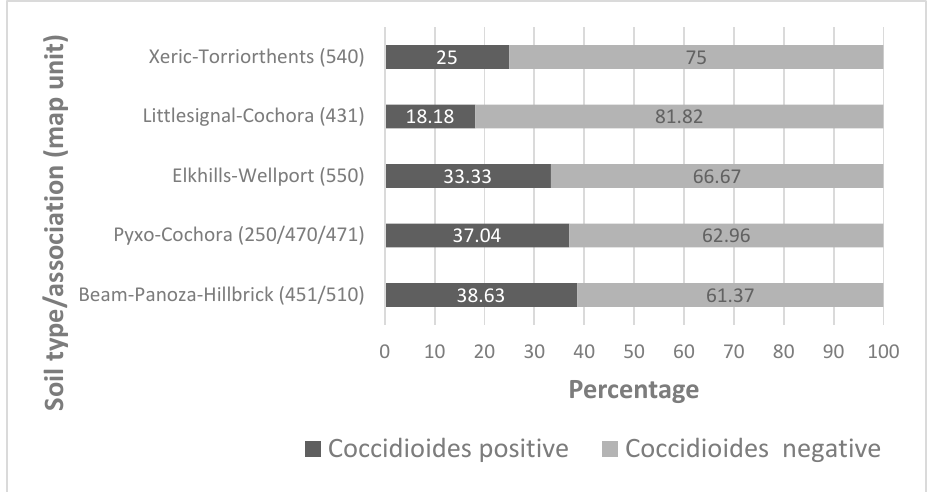
Figure 7. Percentage of Coccidioides -positive and -negative soil samples for different soil types collected between 2018 and 2021 (Xeric–Torriorthents: n = 8, Littlesignal–Cochora: n = 11, Elkills–Wellport: n = 12, Pyxo–Cochora: n = 27, Beam–Panoza–Hillbrick: n = 44).